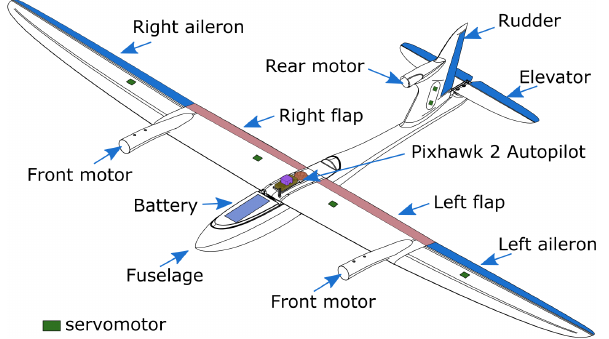
Figure 1. Schematic view of the layout of the